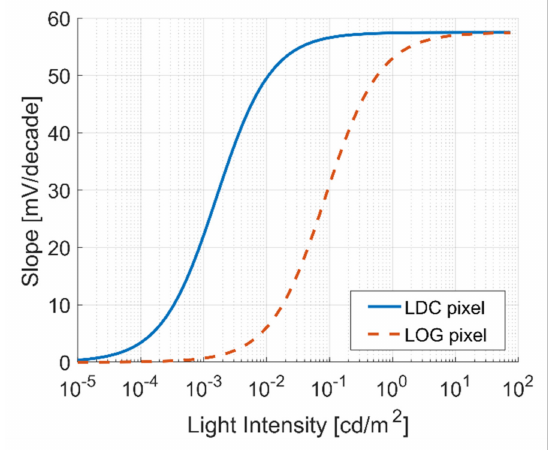
Figure 7. Slope of the measured logarithmic pixel response (red dotted line) compared to the measured proposed low dark current pixel response (blue line).